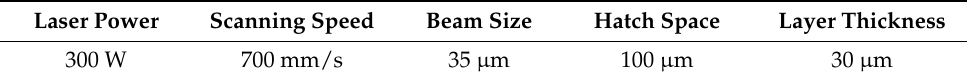
Table 1. Parameters of the selective laser melting (SLM) process.